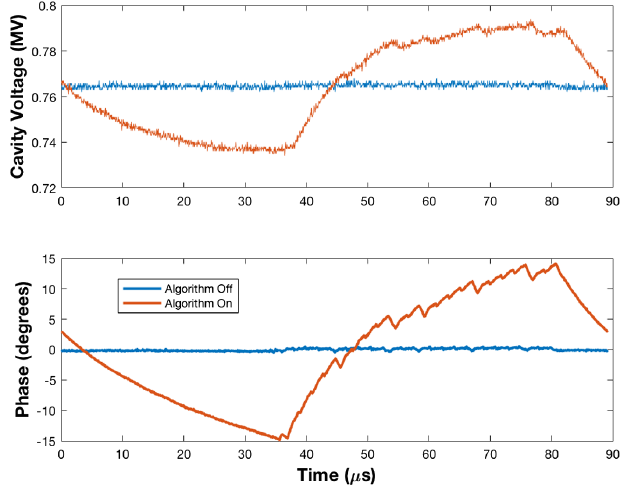
FIG. 3. Cavity voltage with 654 bunches, 50 ns spacing,